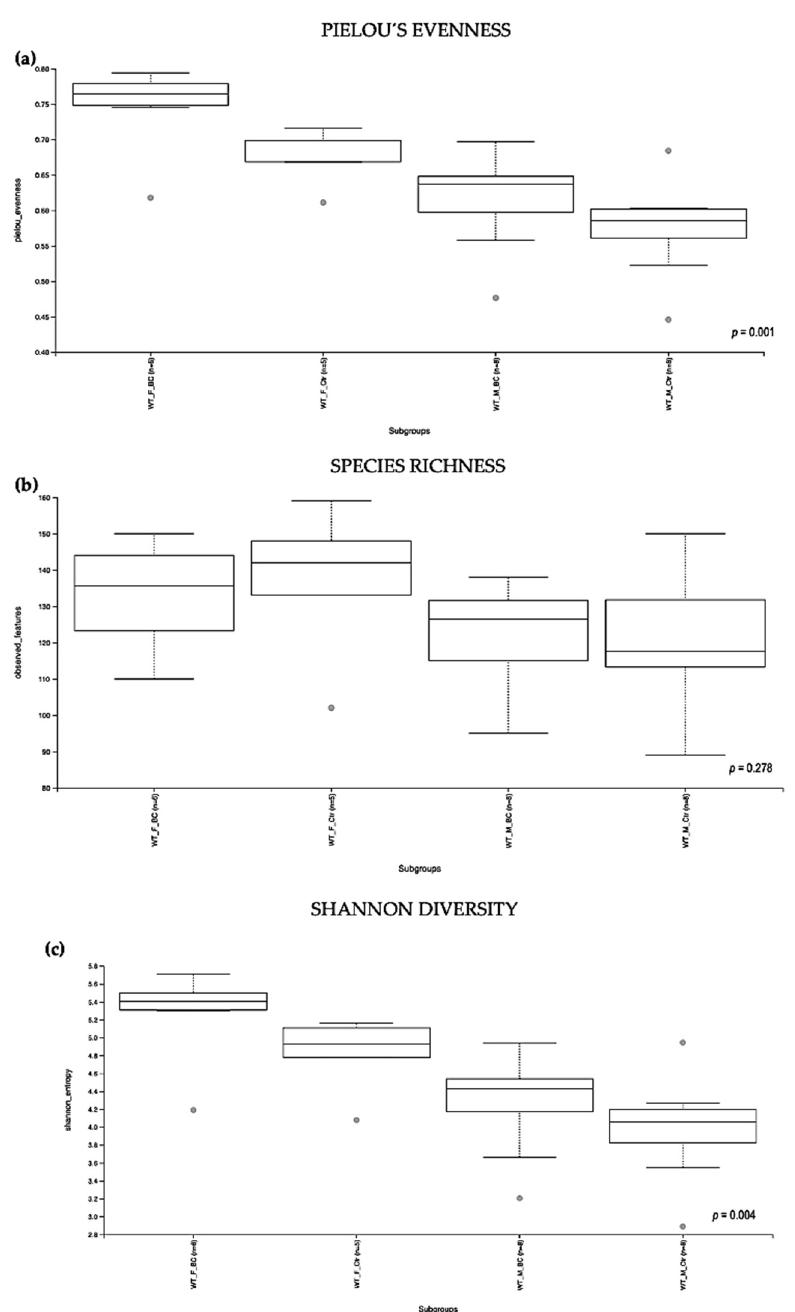
Figure 2. Alpha diversity of the intestinal microbial communities between WT BC and control groups post BC treatment. Comparison of boxplots depicting Pileou ´ s evenness ( a ), species richness ( b ), and Shannon diversity ( c ). Diversity among WT f BC ( n = 6), WT f Ctr ( n = 5), WT m BC ( n = 8), and WT m Ctr ( n = 8) groups. p < 0.05 indicating that the alpha diversity between groups is significant. p values = Kruskal–Wallis rank-sum test (all groups). WT = wild-type mice; BC = bovine colostrum treatment; Ctr = control mice; f = female; m = male; n = number of mice in a group. As indicated by the Shannon index, there was a significant difference in the diversity of microbial community abundances between the WT female and male groups (Kruskal– Wallis Rank-Sum p = 0.004; Figure 2c). When divided by sex, there was a significant difference between the subgroups, i.e., WT f BC vs. WT f Ctr (Kruskal–Wallis pairwise p = 0.04). Per contra, there was no difference between the WT male BC group when compared with the WT male control group (Kruskal–Wallis pairwise p = 0.1; Table 1).